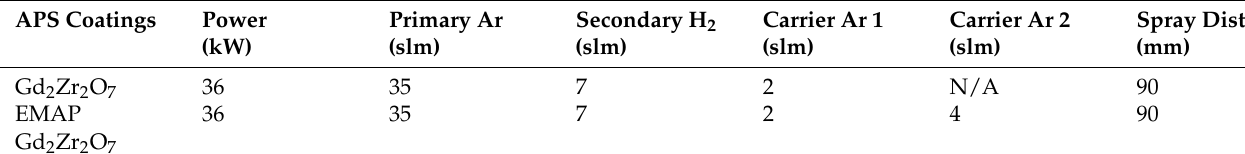
Table 1. Operating parameters used for air plasma spray.